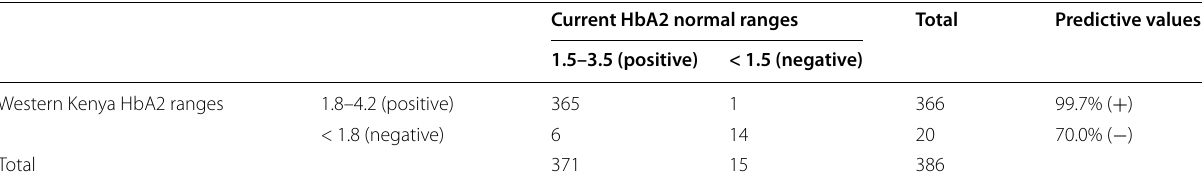
Table 4 Predictive validity of currently HbA2 normal range in western Kenya